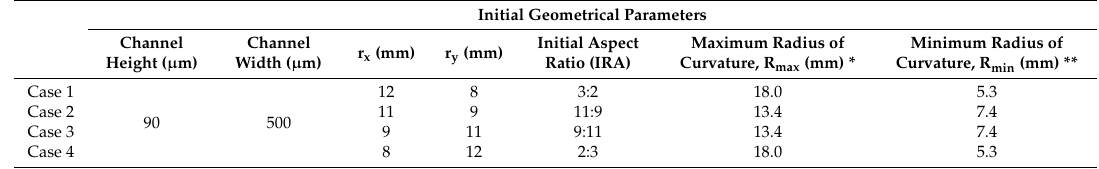
the design of all cases.